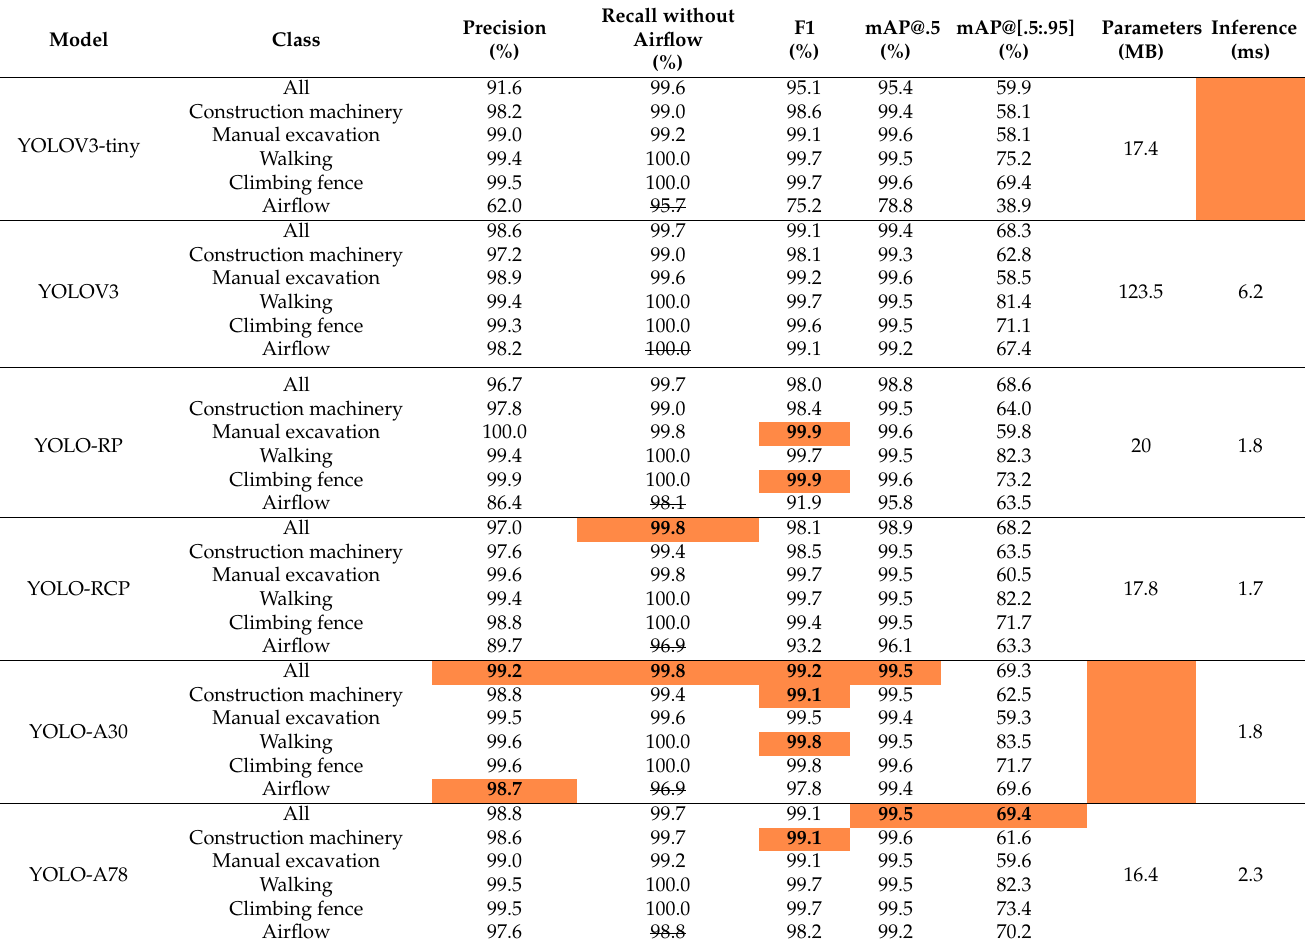
Table 3. Models performance metrics